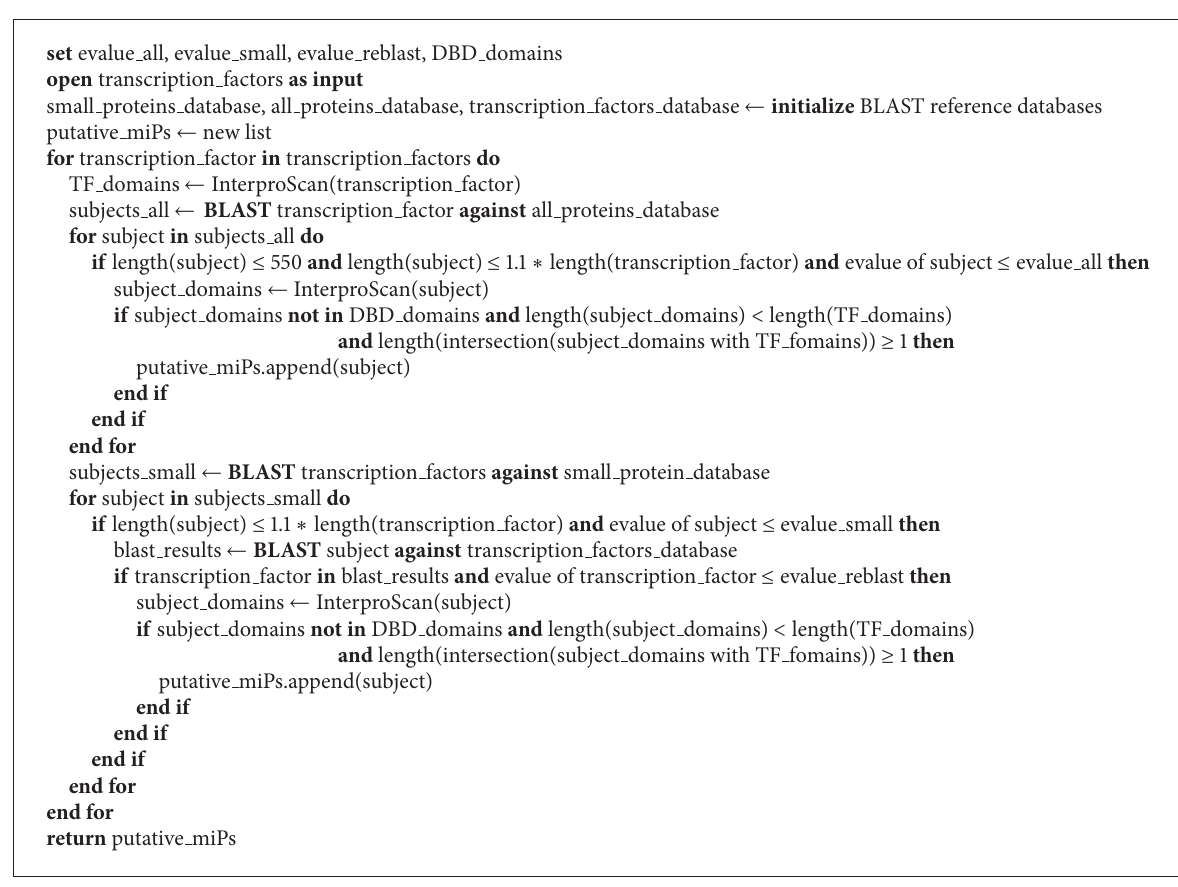
Pseudocode 1: Pseudocode of